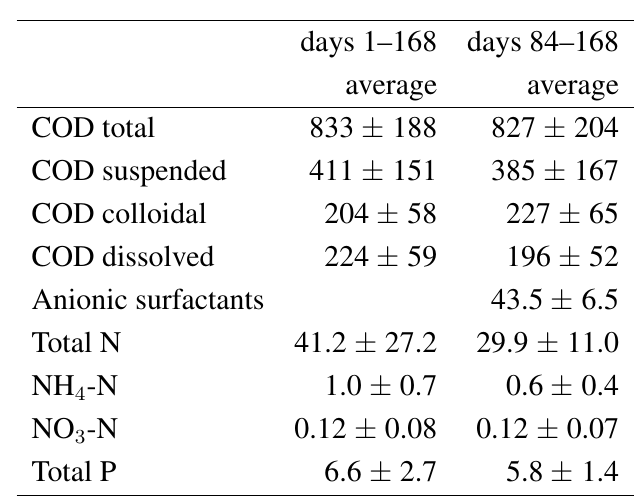
Table 2. Characteristics (averages with standard deviations) of greywater used in this study (all values are in